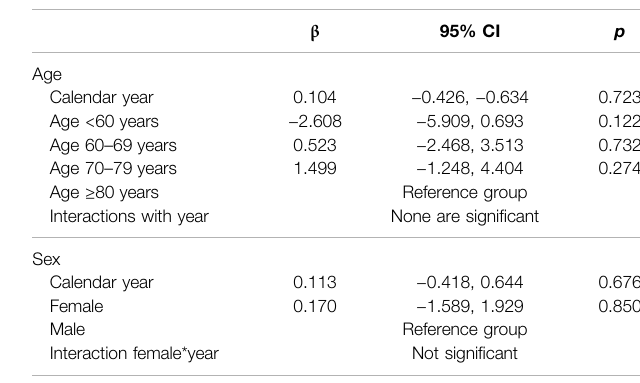
TABLE 4 | In fl uence of age and sex on systolic blood pressure